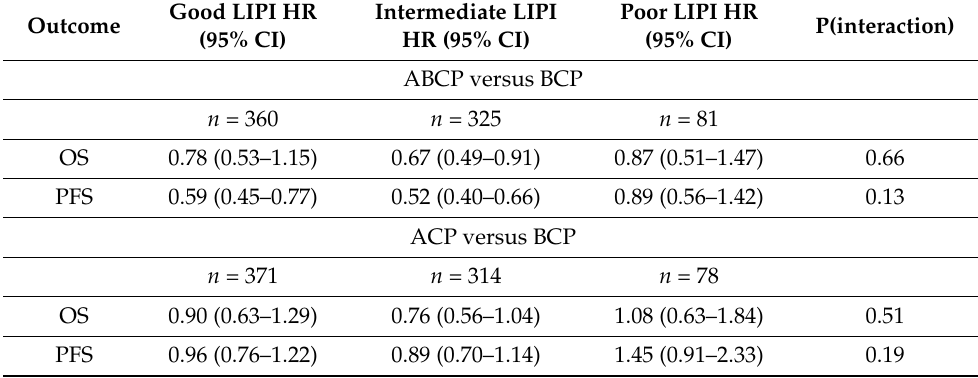
Table 2. Treatment effect modification by LIPI